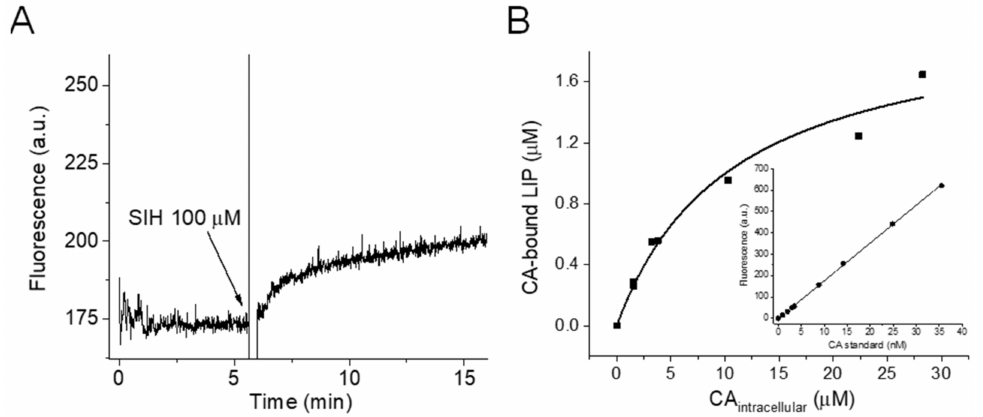
Figure 1. Quantification of the LIP in RAW 264.7 cells. ( A ). Fluorescence trace of Calcein-AM- loaded RAW 264.7 cells upon introduction of SIH. Pre-warmed 3-mL suspensions of 15 × 10 6 cells previously treated with Calcein-AM (0.25, 0.5, 1.0, 2.0, or 3.0 µ M) at 37 ◦ C for 20 min were placed in the fluorimeter. When the baseline was established, SIH (100 µ M) was added, as designated in the plot. The conditions and fluorescence acquisition parameter settings were as follows: PBS, 100 µ M DTPA, pH 7.4, T = 37 ◦ C, λ ex = 495 nm, λ em = 516 nm, ex and em slit width = 3 nm. ( B ).